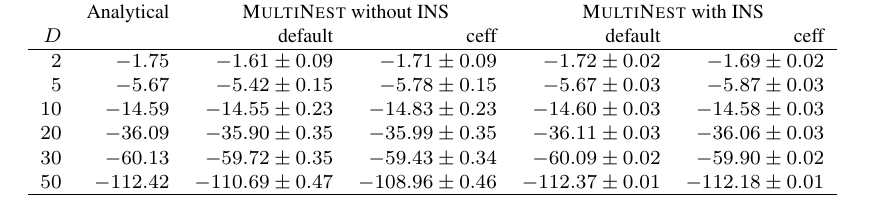
TABLE 2 T HE TRUE AND ESTIMATED log( Z ) FOR TEST PROBLEM 1, DISCUSSED IN S EC . 5.1, AS A FUNCTION OF THE DIMENSIONS D OF THE PARAMETER SPACE , USING M ULTI N EST WITH AND WITHOUT INS AND IN ITS DEFAULT AND CONSTANT EFFICIENCY MODES .